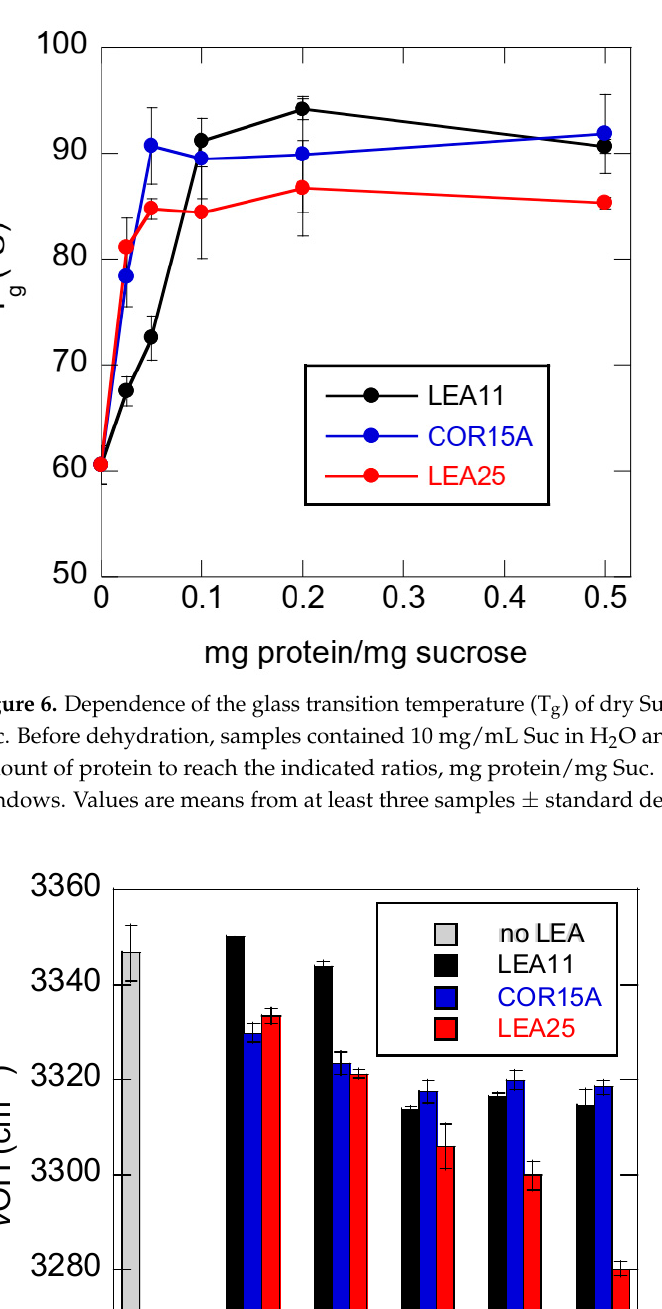
Figure 6. Dependence of the glass transition temperature (T g ) of dry Suc on the ratio mg pro- tein/mg Suc. Before dehydration, samples contained 10 mg/mL Suc in H 2 O and, in addition, the respective amount of protein to reach the indicated ratios, mg protein/mg Suc. Samples were dried on CaF 2 windows. Values are means from at least three samples ± standard deviation.